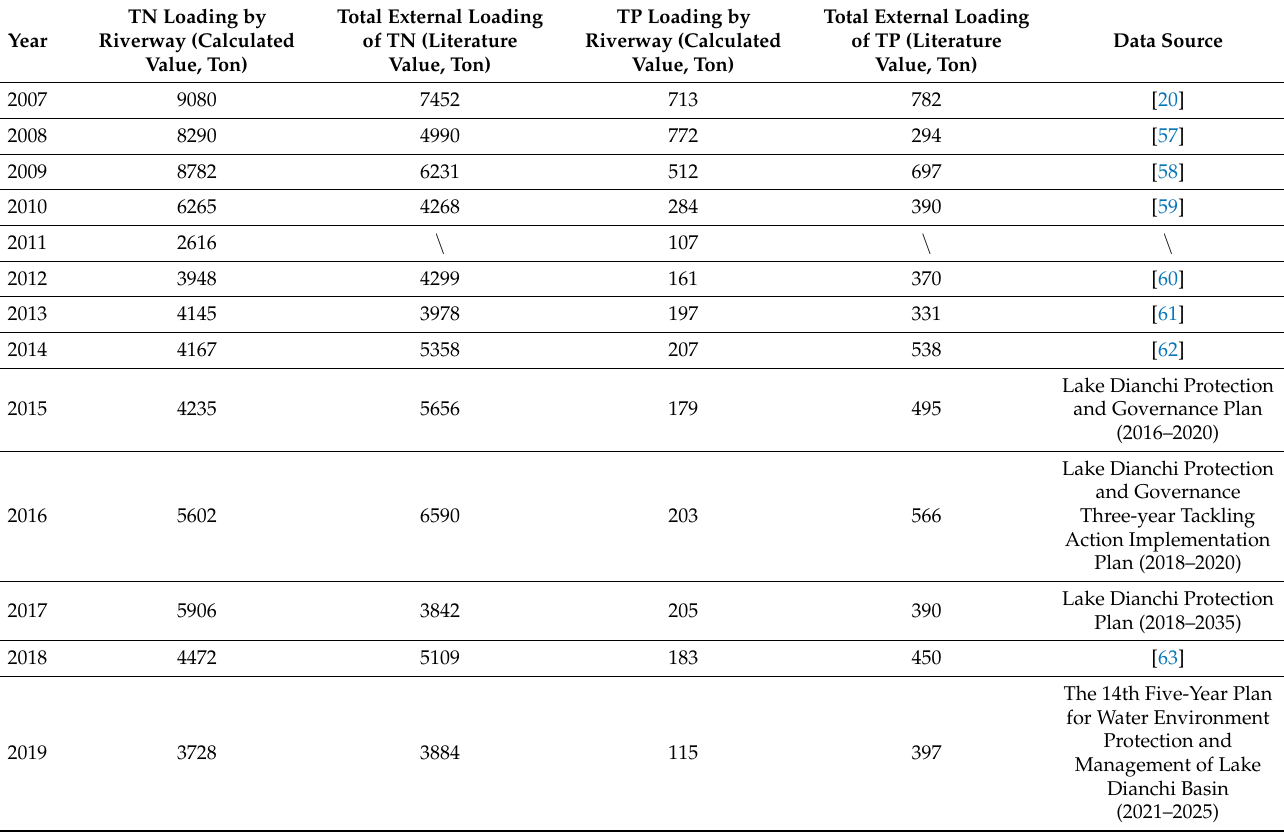
Table 4. Annual external loading of Waihai from 2007 to